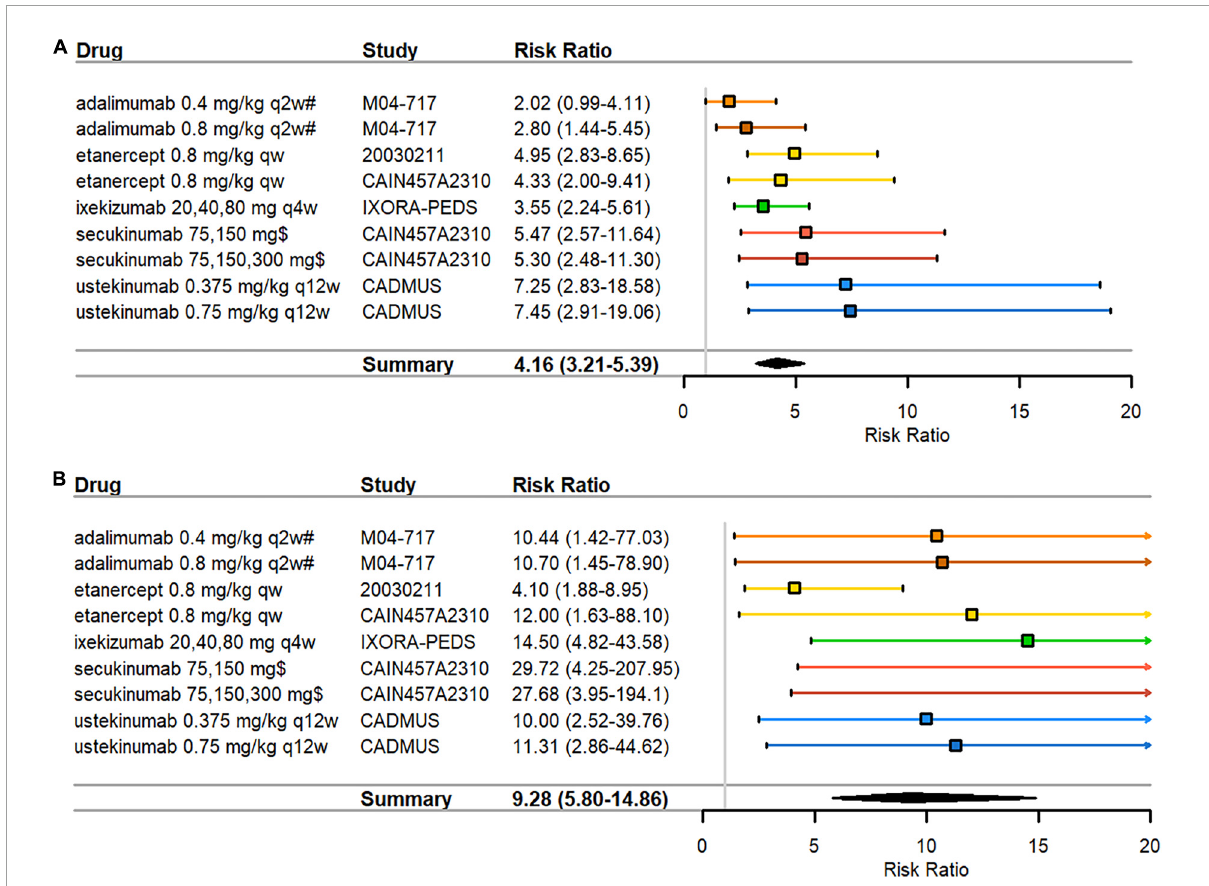
FIGURE2 Pediatric psoriasis RCTs that reported efficacy data at 3 months. (A) PASI75 (B) PASI90 RRs—mean represented by the square—were calculated as percent response in biologics arm divided by percent response in control arm. Overall effect estimate is represented by the diamond, with the width showing the CIs for the overall estimated effect estimate. Further, 95% CIs for RRs—represented by the whiskers—were computed utilizing the exact method. All CIs that did not include 1 indicated significant effects. Experimental treatment is preferred when RR > 1. PASI, Psoriasis Area and Severity Index; qw, every week; q2w, every 2 weeks; q4w, every 4 weeks; q12w, every 12 weeks; RCT, randomized controlled trial; RR, risk ratio. $ dosed at weeks 1, 2, 3, 4, and every 4 weeks thereafter; # compared against methotrexate monotherapy instead of